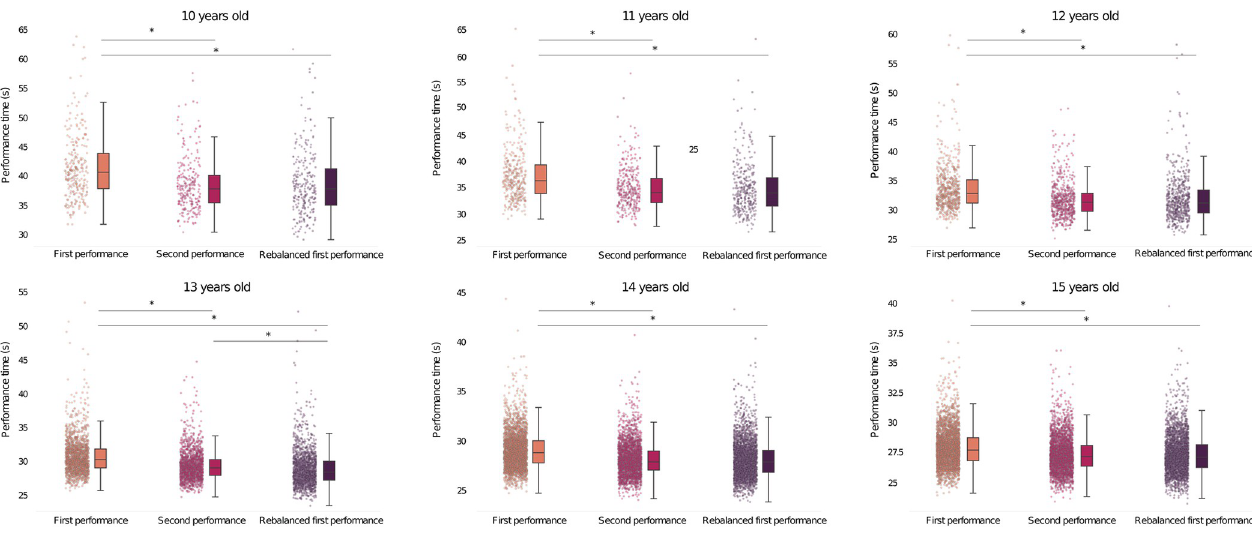
Fig 3. Statistical comparison of first, second and relocated performances. * : Significant mean performance difference (p < 0.01).